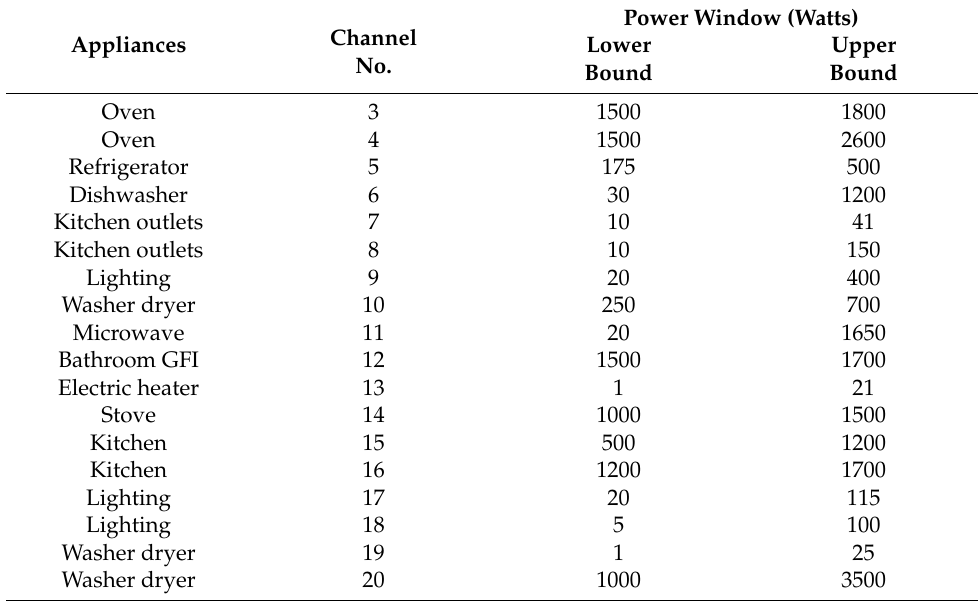
Table 3. Power window of appliances in House 1 in the REDD